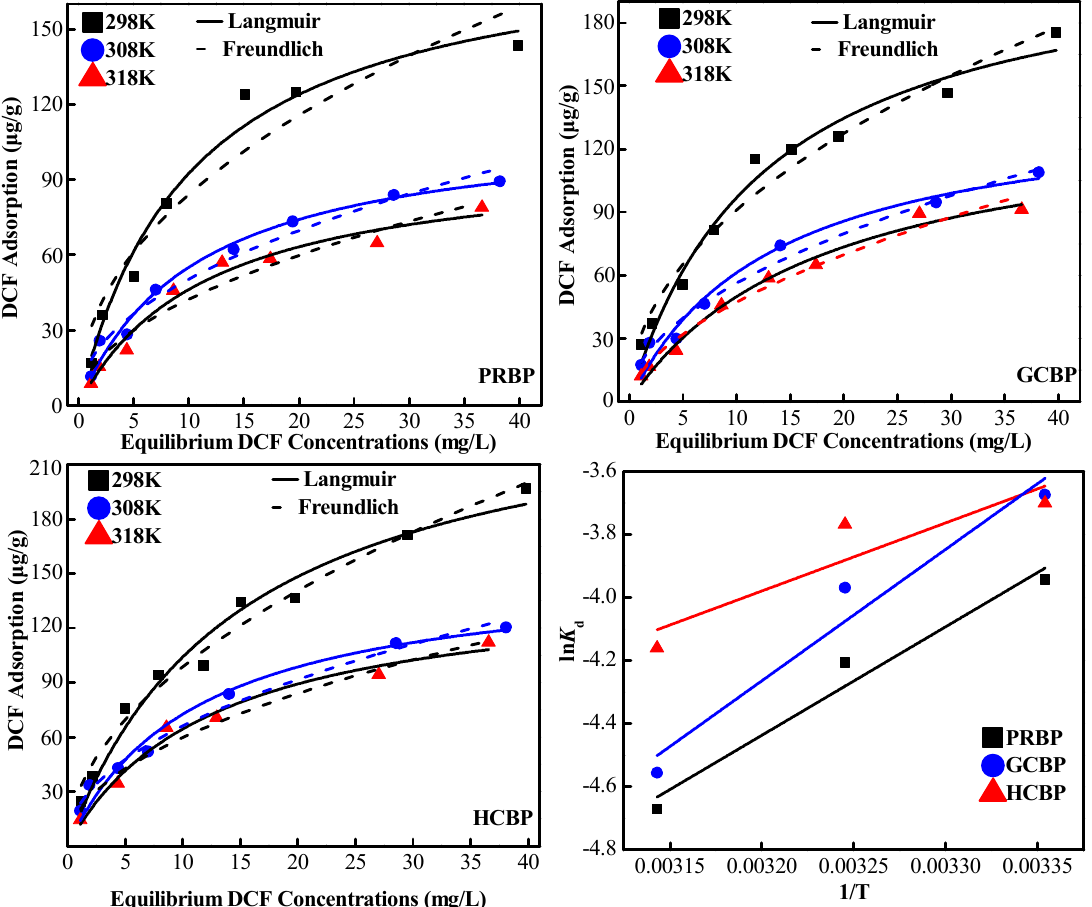
Figure 9. Effect of temperature on the adsorption of DCF onto PRBP, GCBP, and HCBP. Experimental conditions: m = 2 g/L, pH = 7.0 ± 0.1.